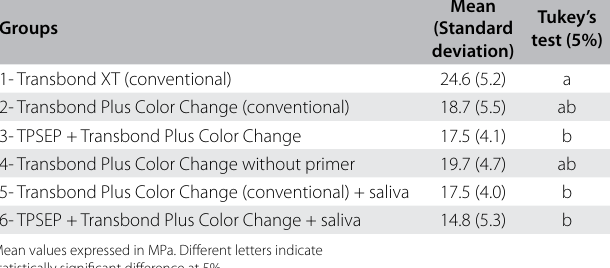
* Bonding agent; **Self-etching pimer from 3M Unitek Table 2. Shear bond strength results Groups